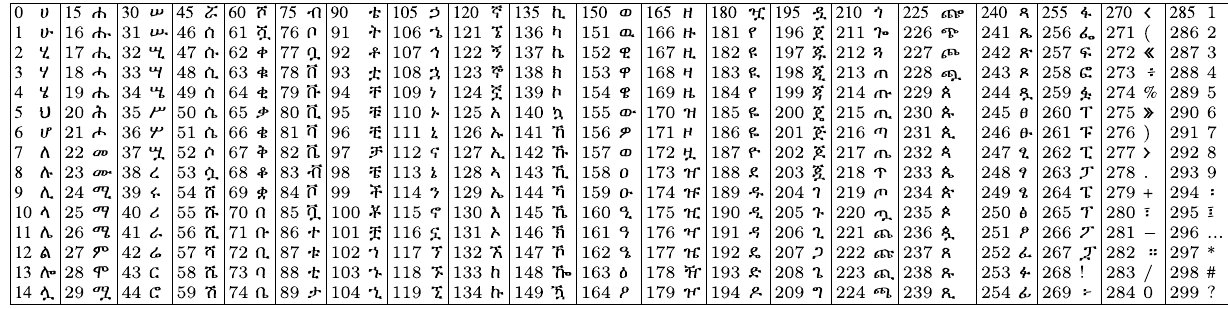
Table 3 Amharic characters and other symbols used in this